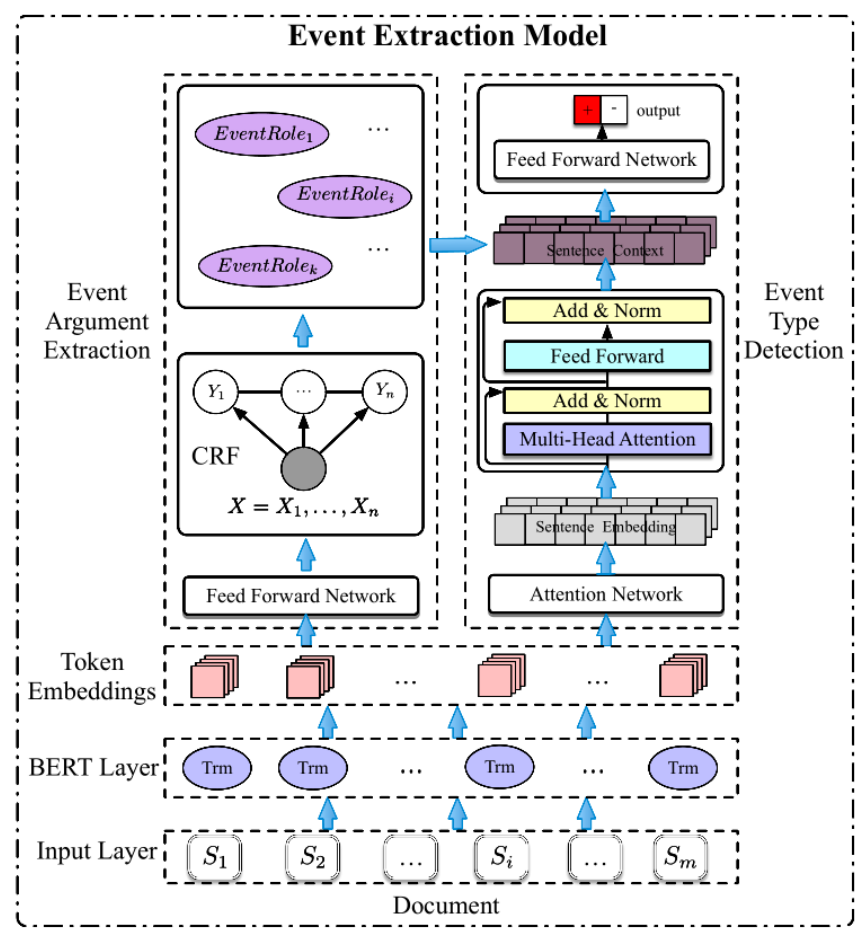
Figure 2. The overview of relation-aware Transformer-based Document-level Joint Event Extraction model (TDJEE